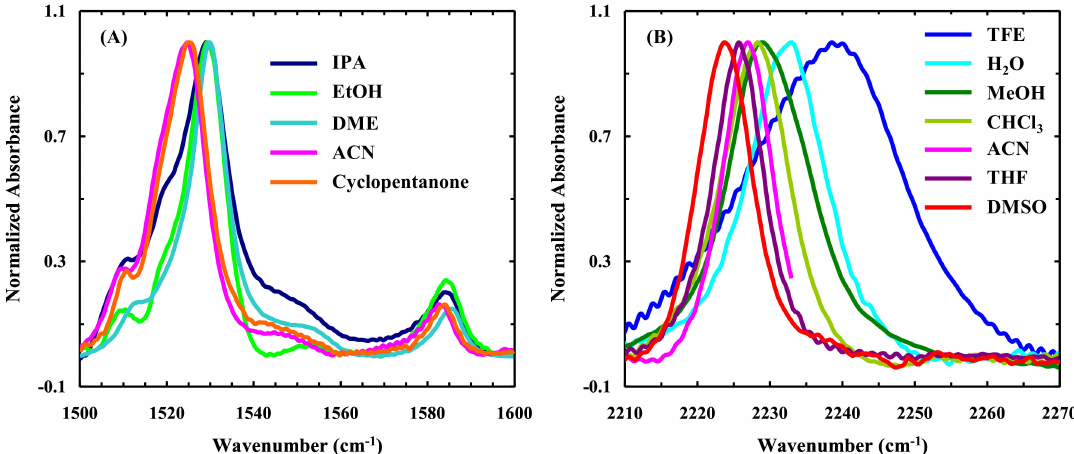
Figure 6. ( A ) FTIR spectra (in the region of the asymmetric stretching vibrational band of the nitro group) of 5-nitroindole (5NI) in isopropanol (IPA), ethanol (EtOH), dimethyl ether (DME), acetonitrile (ACN), and cyclopentanone, as indicated. ( B ) The C ≡ N stretching band of 4-cyanoindole-2 (cid:48) -deoxyribonucleoside (4CNI-NS) in different solvents, as indicated. Only part of the spectrum obtained in ACN is shown, due to the interference of the C ≡ N stretching band of the solvent at 2267 cm − 1 . For easy comparison, the original spectra, which have a maximum absorbance of ~10 mOD, have been